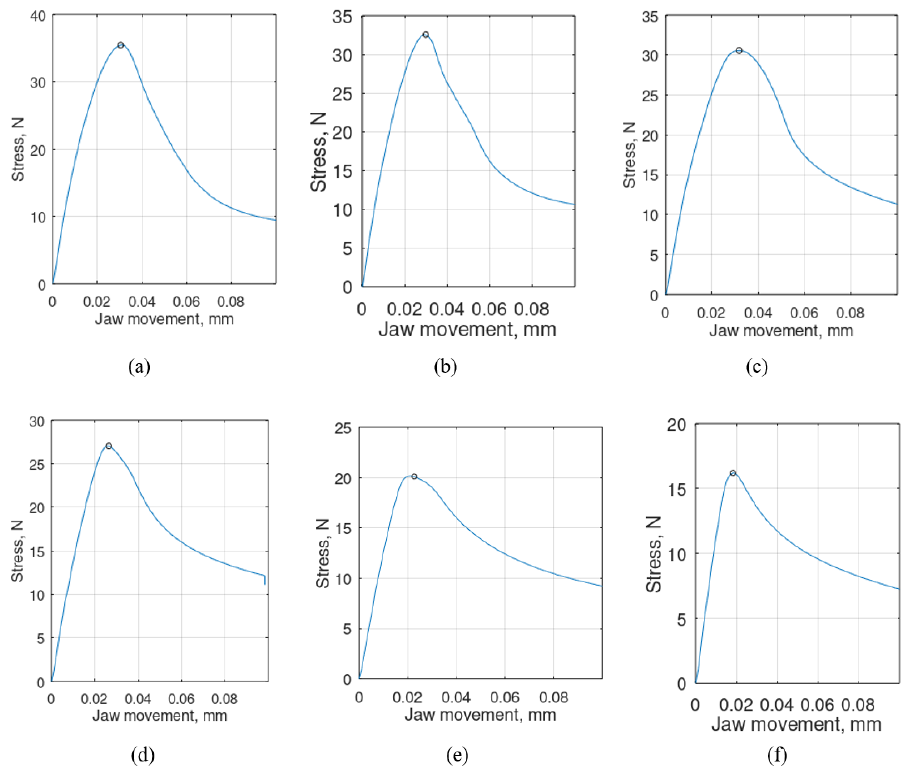
Figure 12. Shape of the dependence of the compressive force of the paper sample on the displacement of the movable handle at the fastening lengths: ( a ) 0.7 mm, ( b ) 1.3 mm, ( c ) 2 mm, ( d ) 3 mm, ( e ) 4 mm, ( f ) 5 mm.